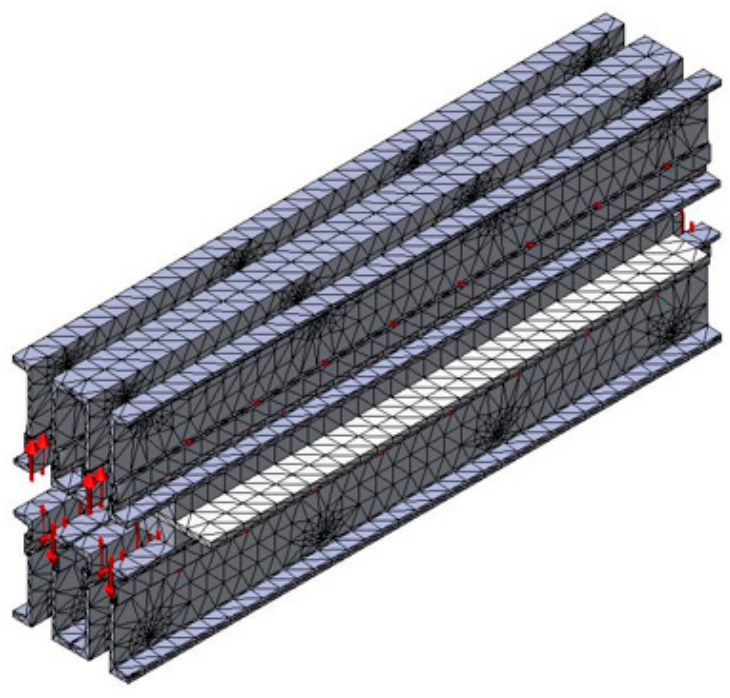
Figure 6. Discretion of the belt vulcanization press.